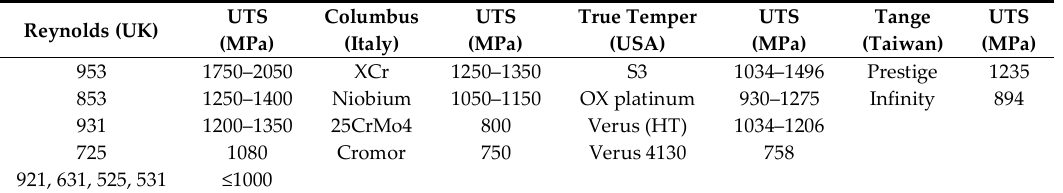
Table 2. Strength data for various types of steel available through the four main international tube manufacturers (Reynolds (UK), Columbus (Italy), True Temper (US), Tange (Taiwan))